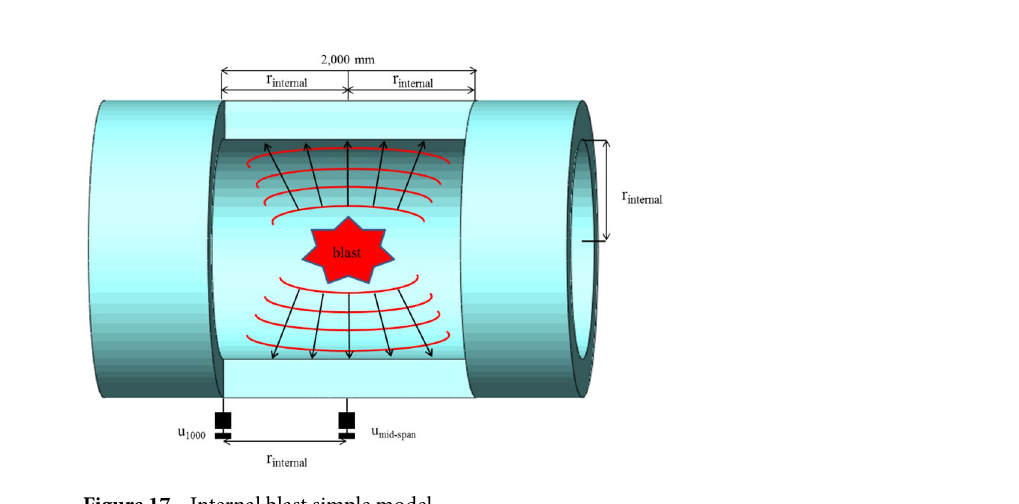
Figure 17. Internal blast simple